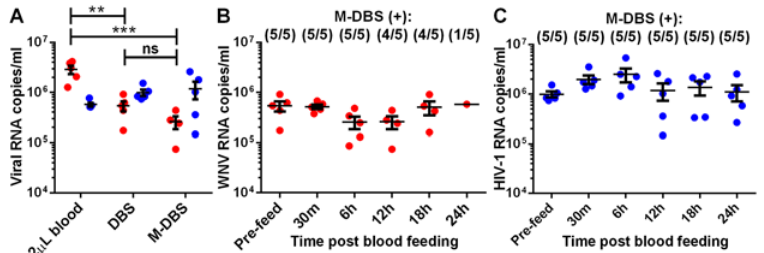
Fig 2. Virus-specific differences between the efficiency and duration of viral RNA detection from M-DBS. WNV (red) or HIV-1 (blue) were mixed with blood at 10 6 viral RNA copies/ml. (A) The means (shown with SEM) of virus-specific RNA detected directly from 2 μ l of blood-virus mix (not applied to FTA cards), 2 μ l of the blood-virus mix applied to FTA cards and mosquito bloodmeals applied to FTA cards 12 h post feeding (hpf) were compared using a one way ANOVA with Tukey ’ s multiple comparisons adjustment. Application of the blood-virus mix (P = 0.0012) and mosquito bloodmeals (P = 0.0008) to FTA cards resulted in significant losses in WNV RNA detection compared to the original blood-virus mix, but not between the treatments applied to FTA cards. Comparisons between HIV-1 treatments were not significant. (B) WNV or (C) HIV-1 mixed with blood were offered to mosquitoes and the bloodmeals were applied to FTA cards at the indicated times post blood feeding. The blood-virus mixes (2 μ l each) were applied to FTA cards before blood feeding (pre-feed) to compare to viral RNA detection from mosquito dried blood spots (M-DBS). The number of blood spots positive ( > 10 4 RNA copies/ml) for virus RNA per dried blood spot tested (n = 5) are shown above each time point. The means (shown with SEM) of the post blood feeding time points were compared to the pre-feed using a one way ANOVA with Dunnet ’ s multiple comparisons adjustment. The comparisons were not